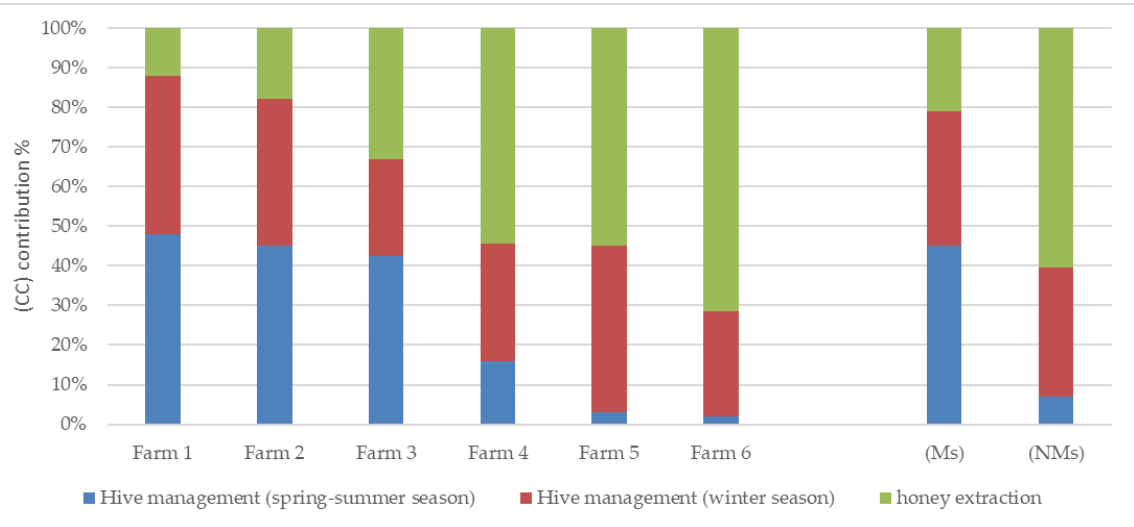
Figure 2. Contribution to climate change (CC) of different beekeeping phases for six farms analyzed in 2020 and 2021. in 2020 and